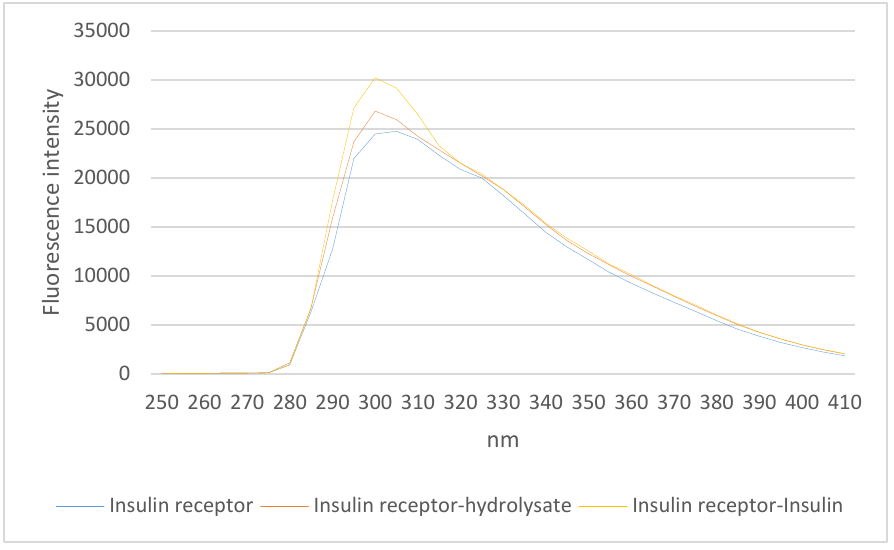
Figure 11. Fluorescence of the insulin receptor (1011-end) and the change in intensity when the insulin receptor – insulin and insulin receptor – hydrolysate complexes are formed.